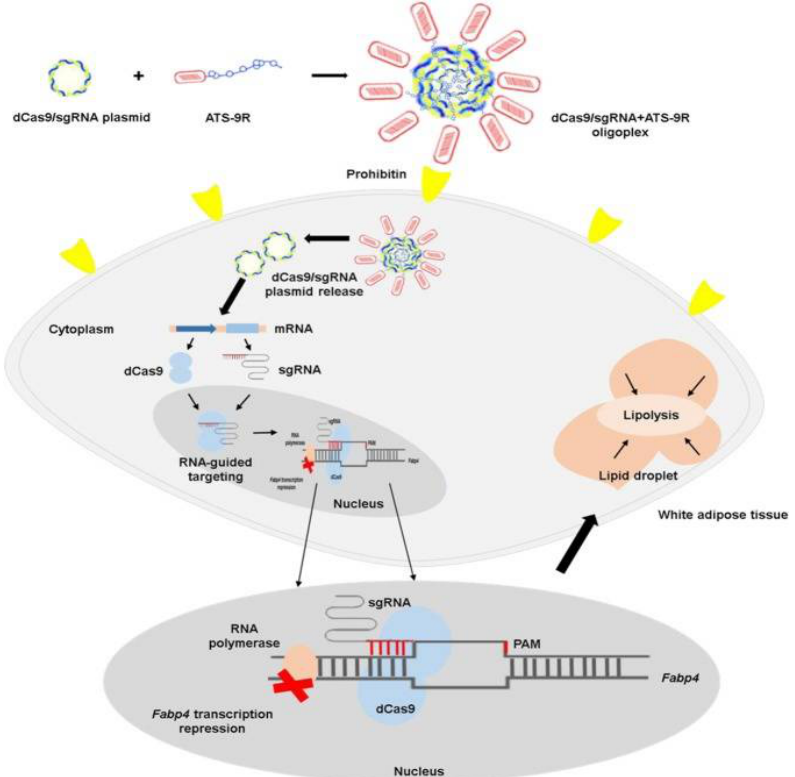
Figure 6. Schematic illustration representing nonviral CRISPR interference system delivery to white adipocytes. The dCas9 plasmid and sgRNA against the Fabp4 gene formed complexes with ATS-9R peptide via electrostatic interaction. The highly cationic ATS-9R functions as a targeting and condensing peptide to deliver dCas9/sgRNA to white adipose tissues, and dCas9 plasmid contains nuclear localization signals (NLSs) on both the N-terminus and C-terminus for delivery to the nucleus. Reproduced with permission [171]. Copyright 2019, Cold Spring Harbor Laboratory Press.